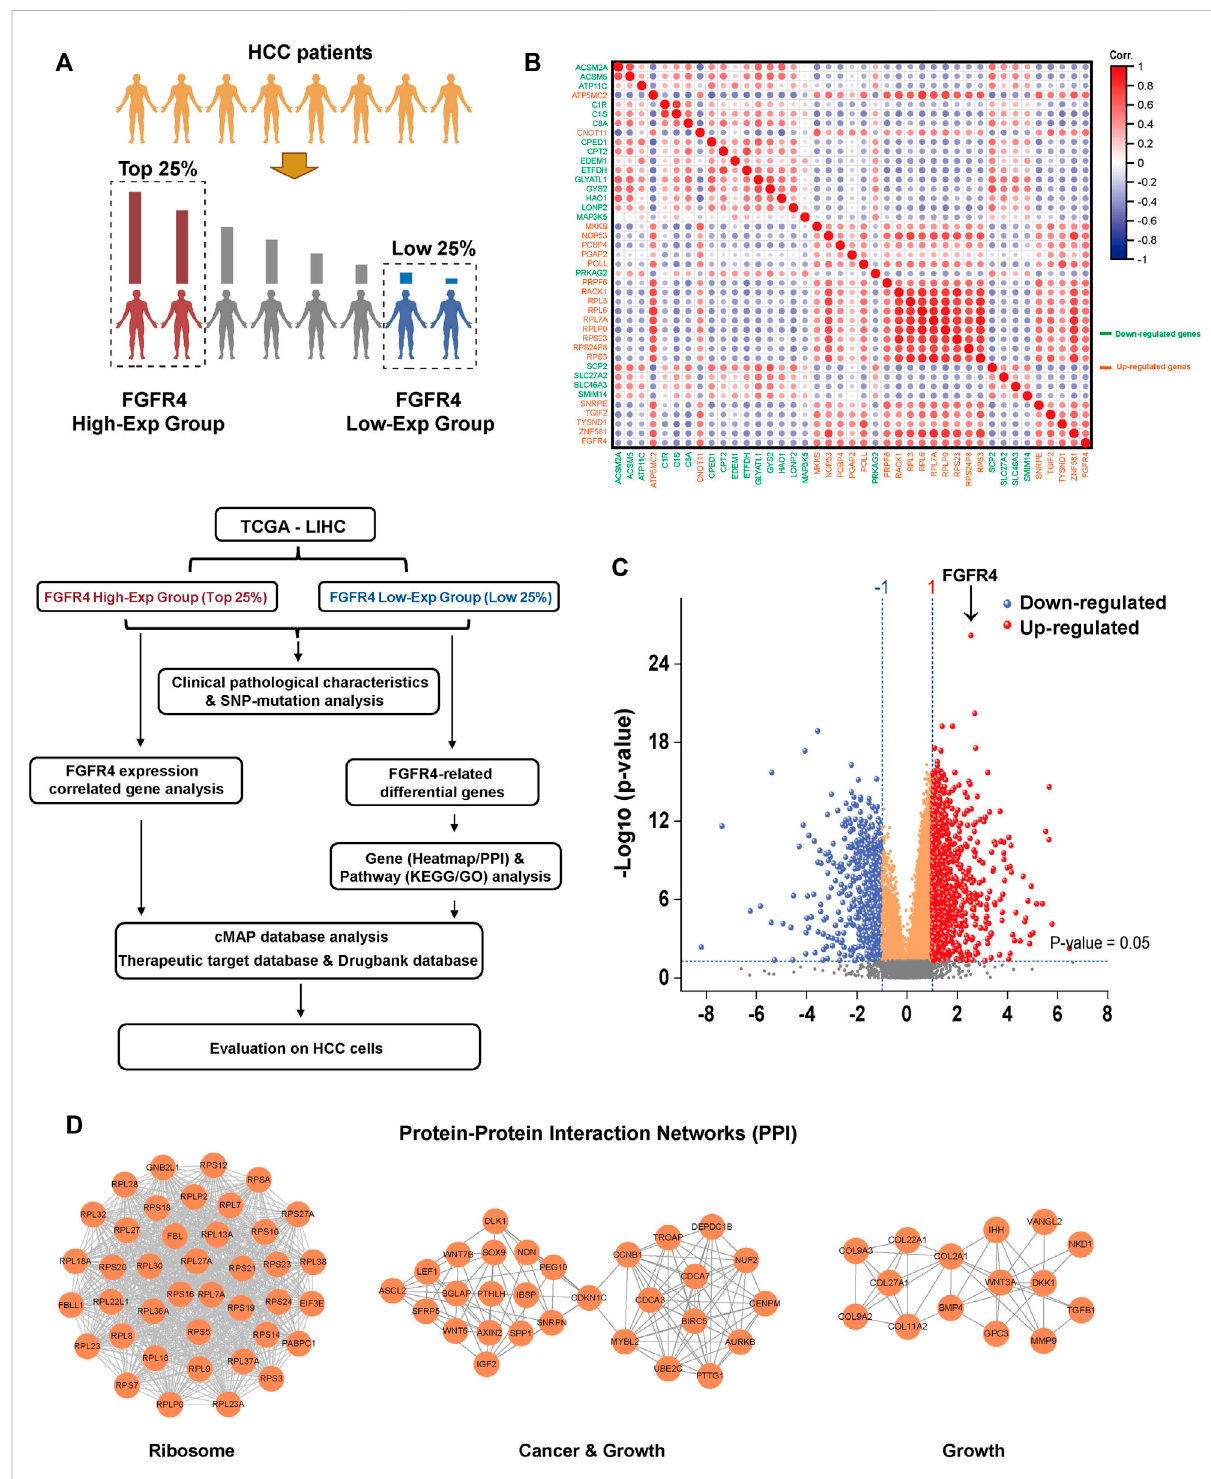
FIGURE 2 Genetic and pathway differences in populations associated with FGFR4 expression differences. (A) In TCGA data, HCC patients were grouped according to the expression of FGFR4 and the research process. (B) Correlation analysis of key top 20 genes expression in FGFR4 high or low expression group. (C) Differential gene volcano map based on FGFR4 high or low expression group. (D) The PPI network top three aggregations of up-regulated genes ( p < 0.05, Log 2 (Fold change) > 1) in the String database based on the FGFR4 high or low expression